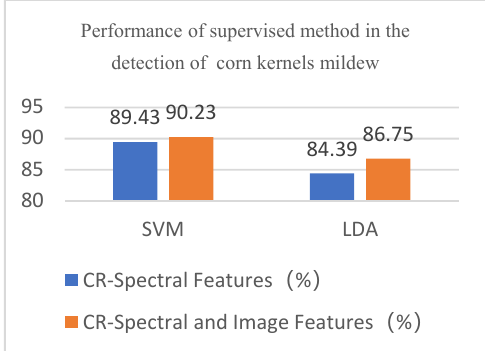
Figure 14. Comparison of the performance of different classification methods.